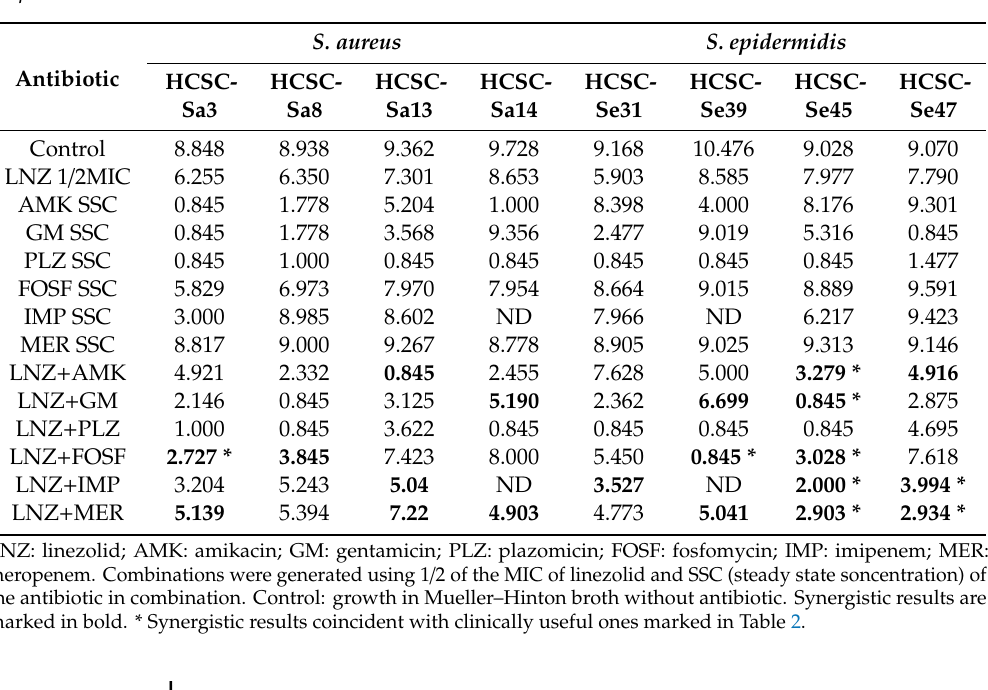
Table 3. Log CFU / mL at 24 h for di ff erent antibiotics and combinations of 4 S. aureus and 4 S. epidermidis isolates.